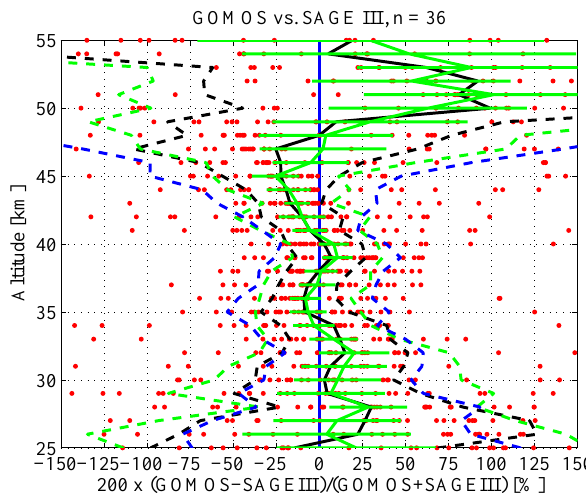
Fig. 5. The statistics of the collocated GOMOS-SAGE III pairs from the years 2002–2004. The black solid line is the median of the in- dividual differences, and the black dashed lines correspond to me- dian ± interquartile deviation. The green solid line is the median fil- tered mean, and the green horizontal lines represent its 95% confi- dence limits. The green dashed lines correspond to mean ± standard deviation, and the blue dashed lines correspond to mean ± square root of the median variance as defined in Eq. (2).